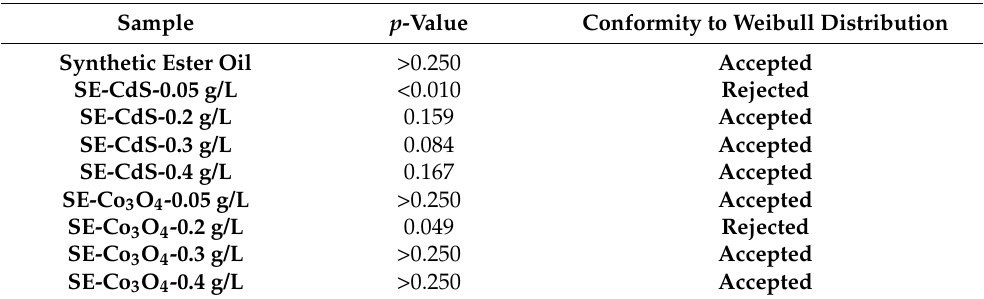
Table 3. Conformity of average AC breakdown voltage to a Weibull distribution for synthetic ester and